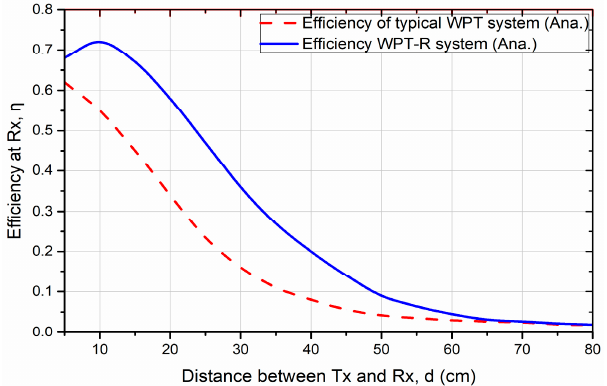
Figure 4. The comparison of simulated harvested power efficiency between typical wireless power transfer (WPT) and wireless power transfer using a relay resonator (WPT-R) systems.